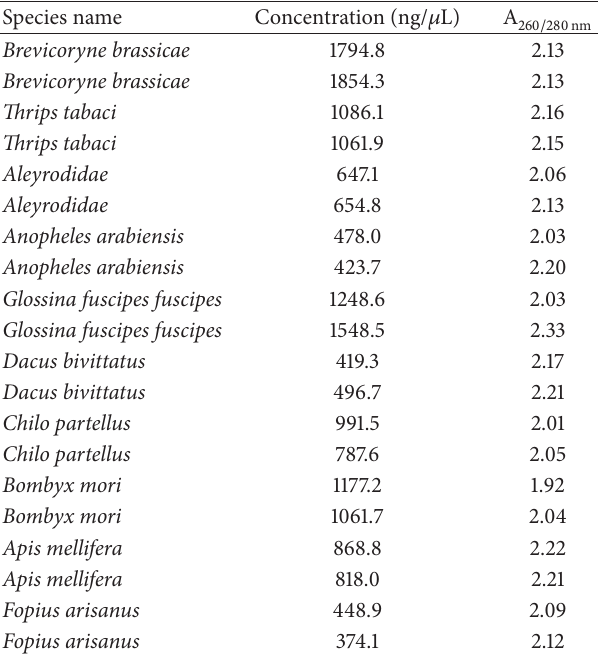
Table 2: Species names of 28S rDNA sequences used in comparative analysis alongside associated GenBank IDs, percentage GC content, and length in base